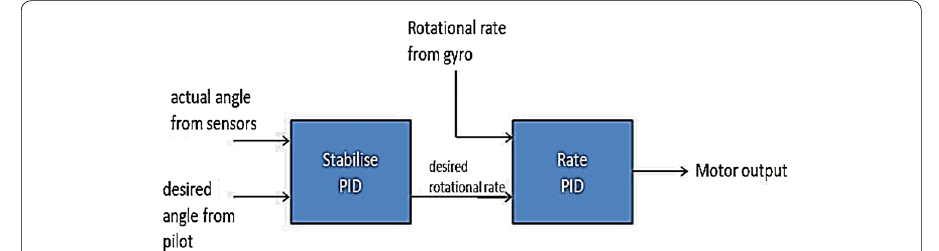
Fig. 3 PID structure at each of the coordinate